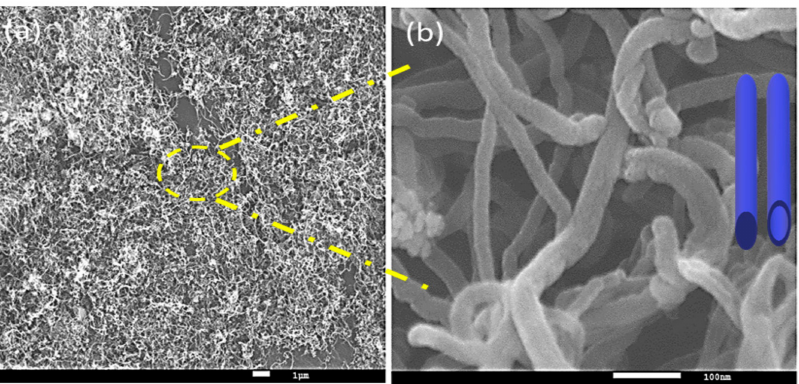
Figure 5. ( a ) SEM image of carbon nanotubes formed on 40%Fe/Al 2 O 3 catalyst and ( b ) SEM image at a high magnification of the marked area in ( a ). The shape in ( b ) shows the proposed 3D model of carbon nanotubes. Reprinted with permission from ref. [28]. Copyright 2015